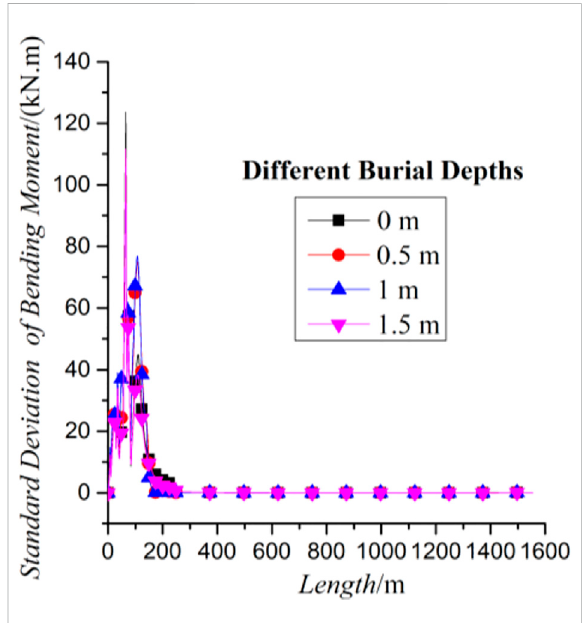
FIGURE 11 Standard deviation of the bending moment of the pipeline in the length with different burial depths.